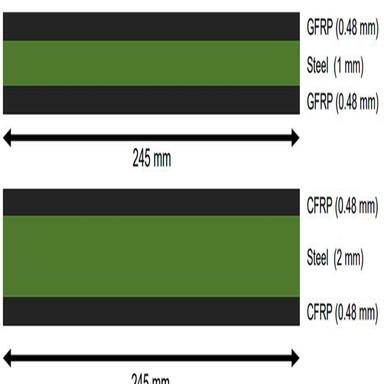
Dimensions of the samples used for residual stress analysis from side view (a) GFRP/steel/GFRP and (b) CFRP/steel/CFRP (the width of both samples is 30 mm, see text for details).